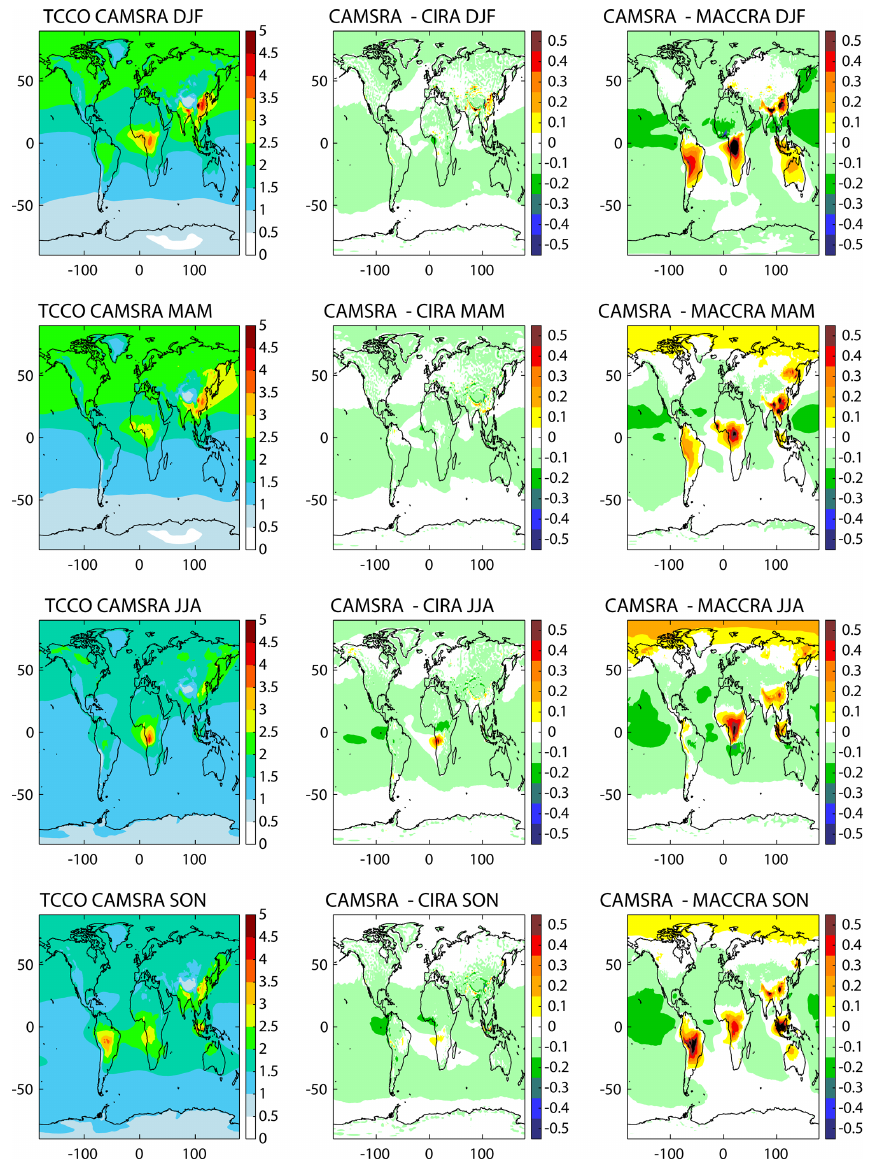
Figure 12. Seasonally averaged TCCO from CAMSRA (2003–2016, left), difference between CAMSRA and CIRA (middle), and difference between CAMSRA and MACCRA (right, 2003–2012 only) in 10 18 moleccm − 2 for the seasons DJF (row 1), MAM (row 2), JJA (row 3) and SON (row